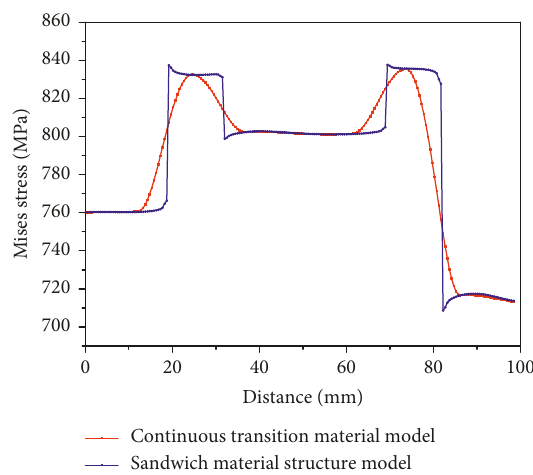
Figure 5: X -direction Mises stress curve of welding joint.